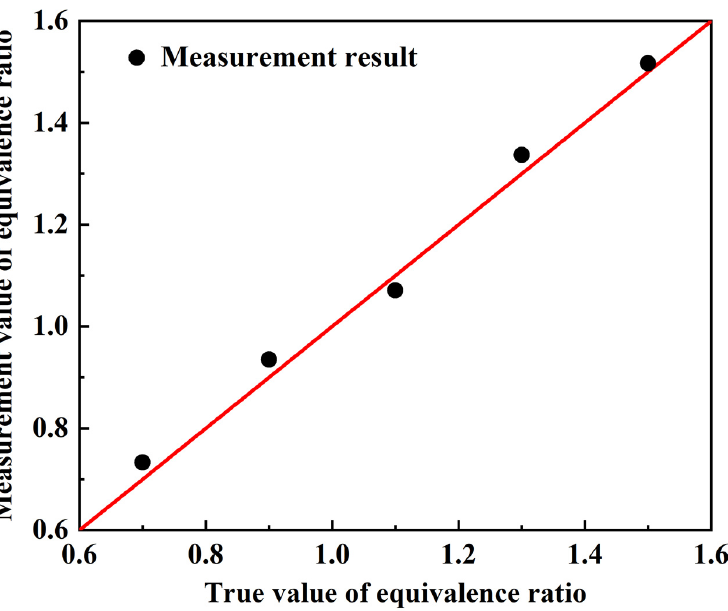
Figure 9. Verification experimental results of equivalence ratio measurement method based on signal relative position.